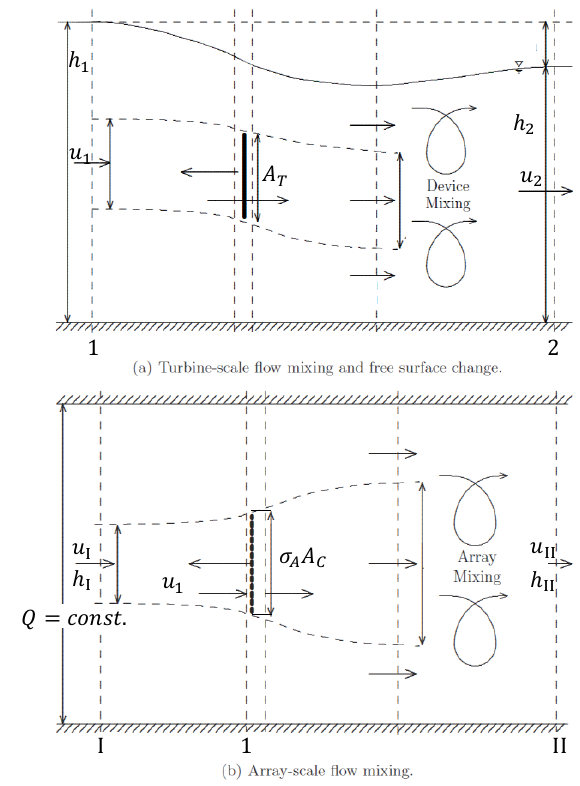
Fig. 6. Top view (b) of the array from Vogel et al. (model III) and side view (b) of the associated turbine model (ii). The authors assume the incoming volume flow as unaltered by the array operation, i.e. Q is constant. (adopted from